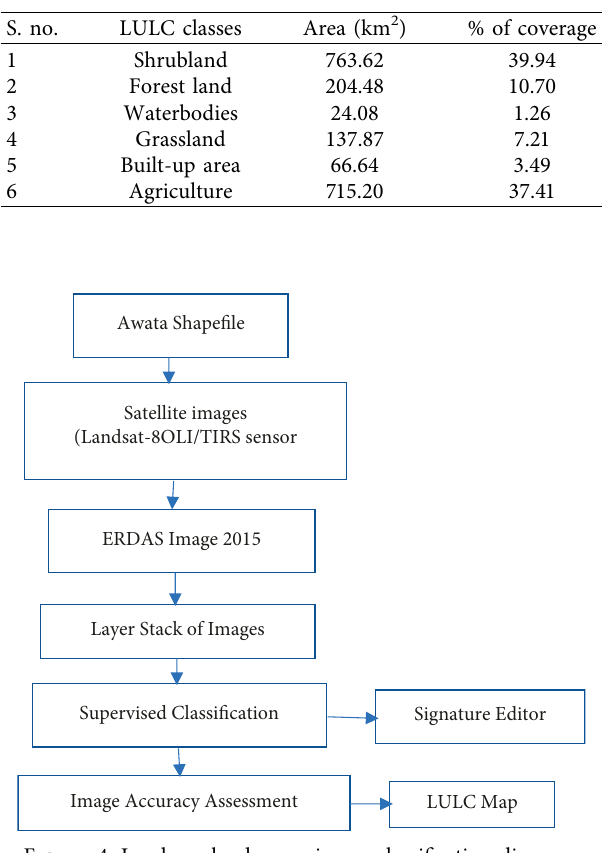
Figure 4: Land use land cover image classification